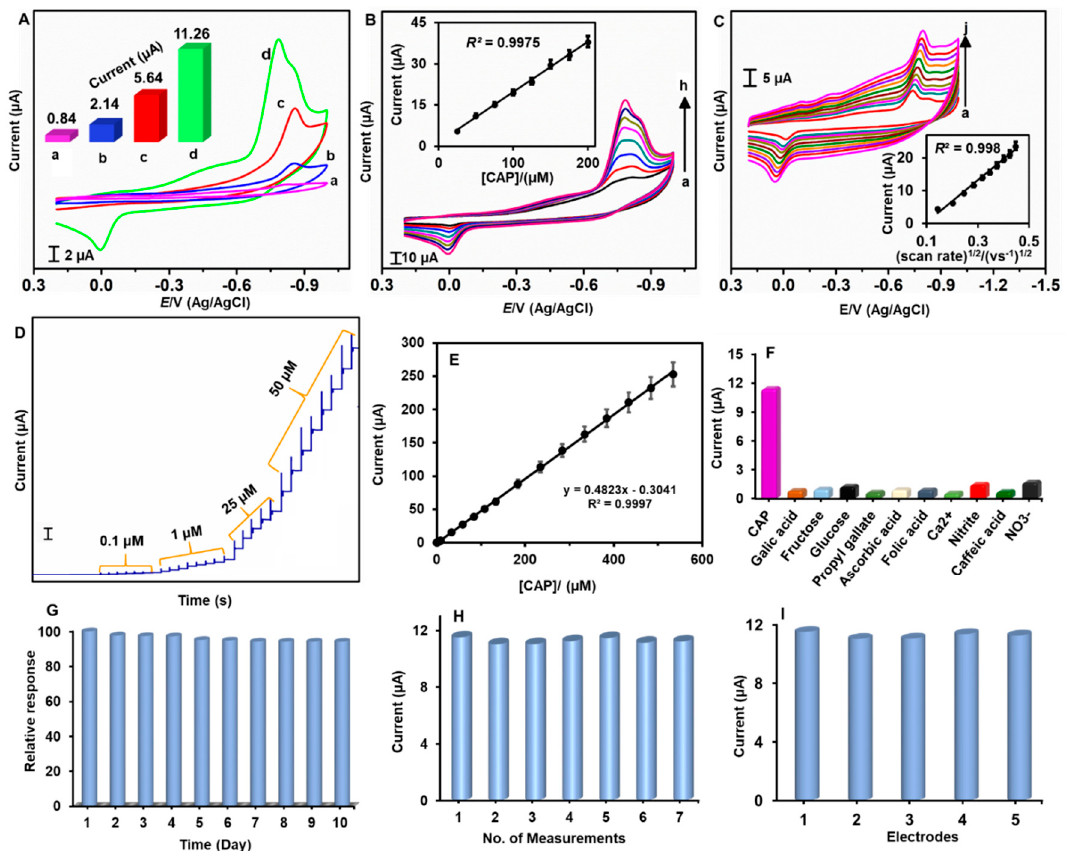
Figure 5. ( A ) Cyclic voltammograms (CVs) at a scan rate of 0.05 V s − 1 obtained for (a) unmodified, (b) CNTs / PDA, (c) CNTs / AuNPs, and (d) CNTs / PDA / AuNPs films-modified glassy carbon electrodes (GCEs) in phosphate bu ff er (pH 7.0) containing 50 µ M of CAP. ( B ) CVs of GCE / CNTs / PDA / AuNPs in phosphate bu ff er (pH 7.0) with varied concentrations of CAP (a = 25, b = 50, c = 75, d = 100, e = 125, f = 150, g = 175, and h = 200 µ M). Inset: cathodic peak current / µ A versus [CAP] / µ M. ( C ) CVs at di ff erent scan rates (a to j: 0.02 to 0.2 V s − 1 ) of GCE / CNTs / PDA / AuNPs in phosphate bu ff er (pH 7.0) containing 50 µ M CAP. Inset: CAP reduction peak current versus (scan rate) 1 / 2 . ( D ) Amperometric response of GCE / CNTs / PDA / AuNPs to varied amounts of CAP, injected in phosphate bu ff er (pH 7.0), and ( E ) corresponding linear calibration plot. ( F ) Amperometric responses of GCE / CNTs / PDA / AuNPs to 50 µ M CAP and 0.1 mM of other analytes. ( G ) CAP sensing performance of GCE / CNTs / PDA / AuNPs for 10 continuous days (stability test), ( H ) 7 repeated measurements using a single electrode (repeatability test) and ( I ) reproducibility of 5 separate experiments using 5 separately fabricated